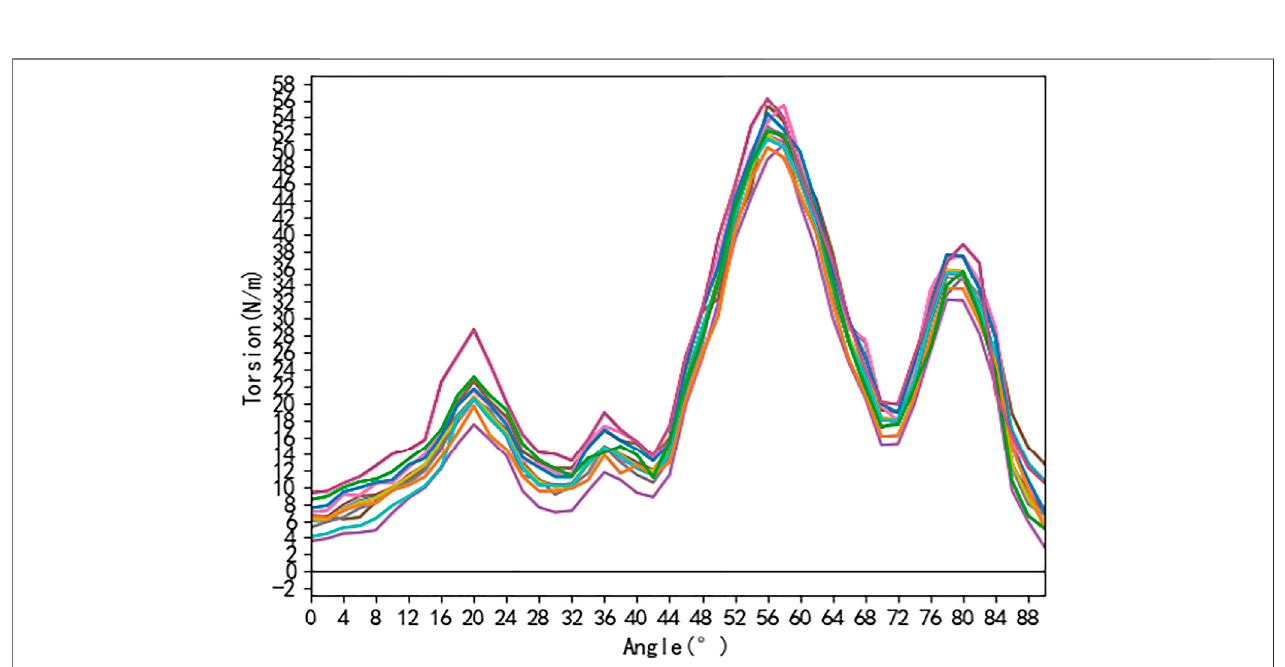
FIGURE 10 | Mechanical locking jam